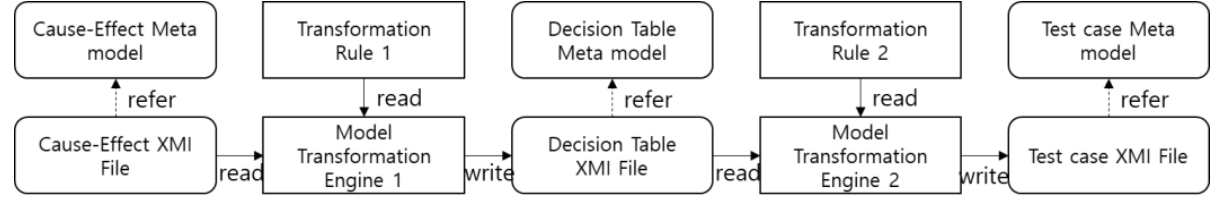
Figure 2. The Model transformations [4].